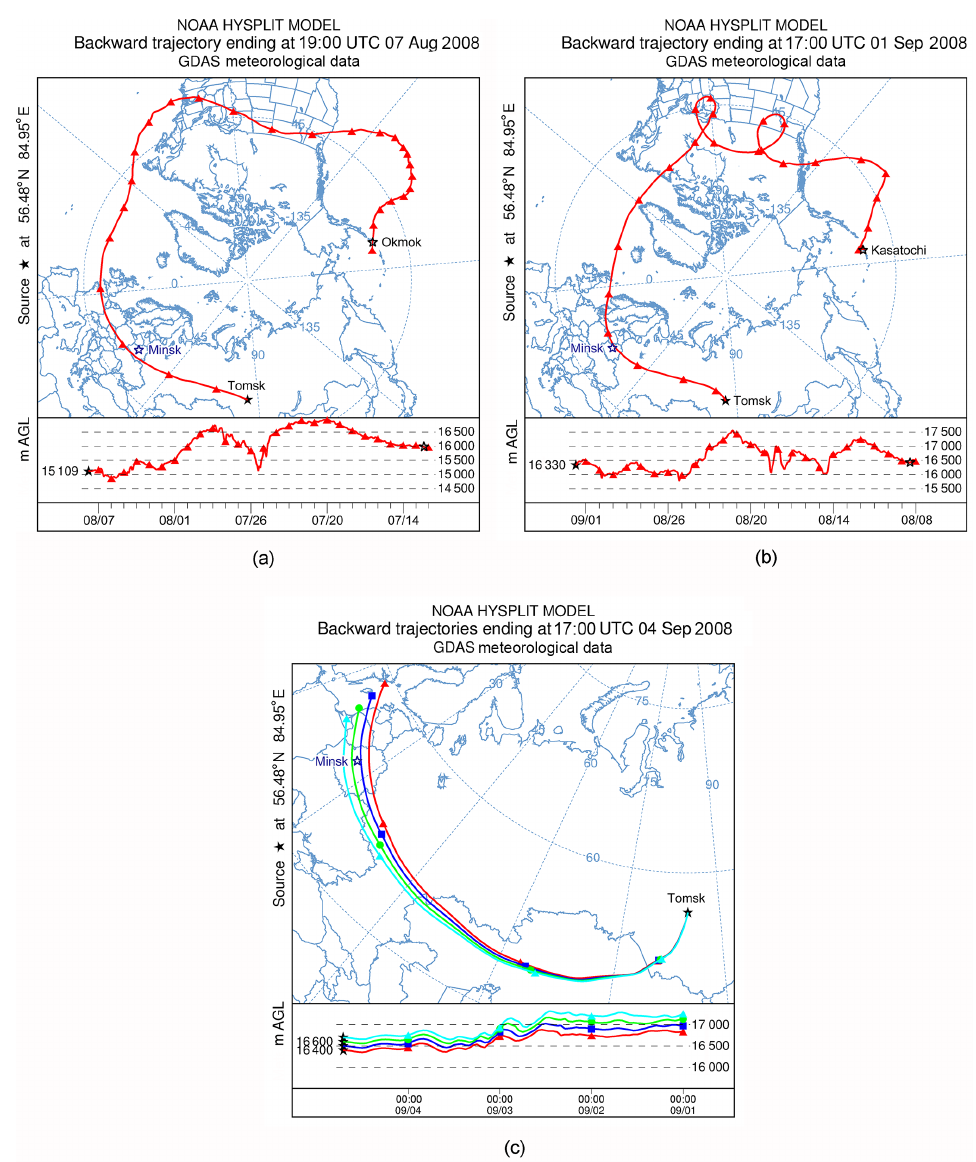
Figure 6. (a) Air mass backward trajectory started from an altitude of ∼ 15.1kma.s.l. over Tomsk on 8 August 2008 at 02:00LT (7 August, 19:00UTC) and passed over Okmok volcano. (b) Air mass backward trajectory started from an altitude of ∼ 16.3kma.s.l. over Tomsk on 2 September 2008 at 00:00LT (1 September, 17:00UTC) and passed over Kasatochi volcano. (c) Air mass backward ensemble trajectories started from altitudes of 16.4–16.7kma.s.l. over Tomsk on 5 September 2008 at 00:00LT (4 September, 17:00UTC) and passed close to